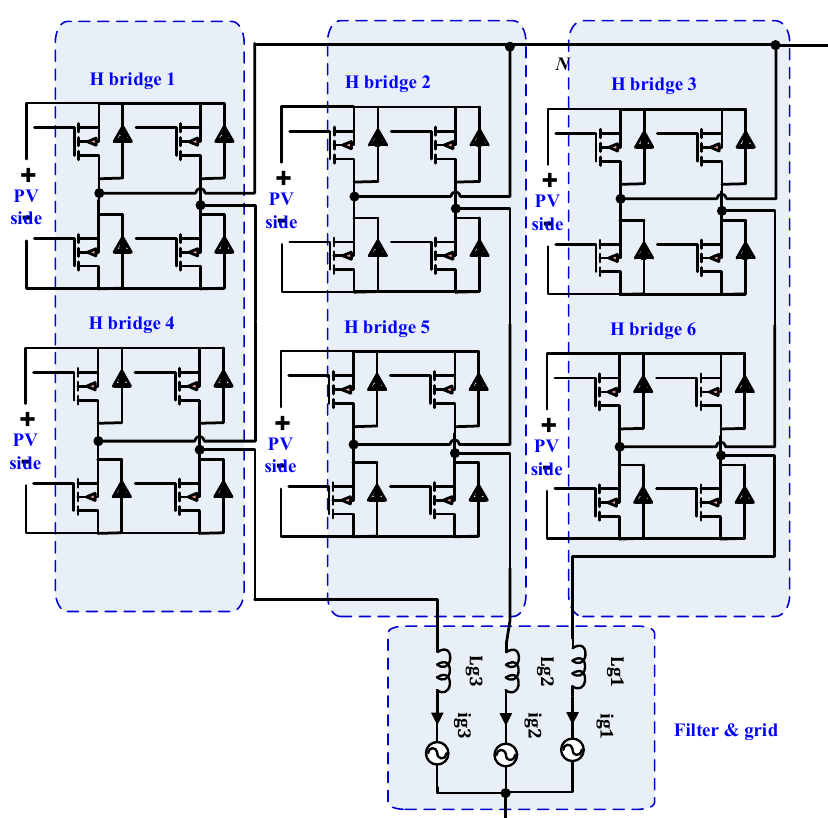
Figure 23. Multi-input three-phase cascaded H-bridge inverter in single-delta bridge cells configuration [114].